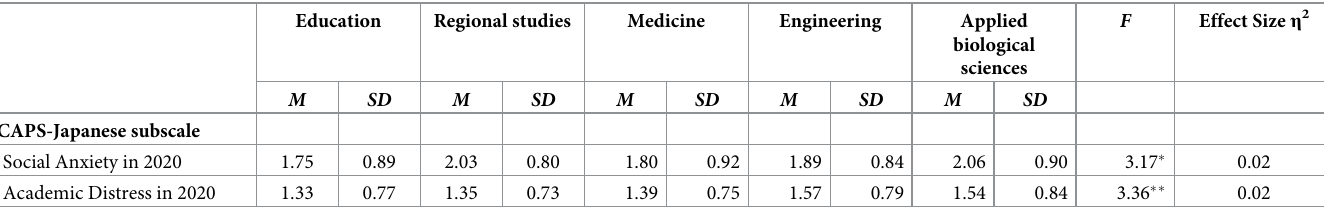
Table 4. Differences by academic department in the CCAPS-Japanese